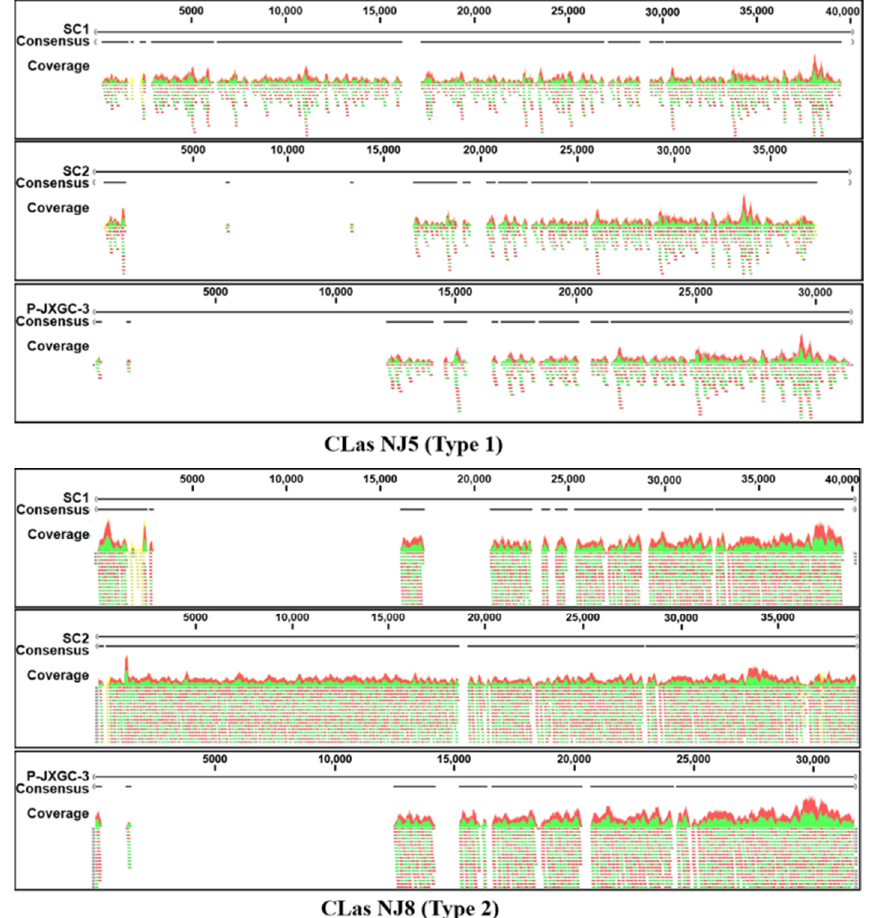
Figure 2. Results of HiSeq read mapping of “ Candidatus Liberibacter asiaticus” (CLas) strains NJ5-T1 and NJ8-T2 to the sequences of phage/prophage SC1 (Type 1, HQ377372), SC2 (Type 2, HQ377373) and P-JXGC-3 (Type 3, KY661963). Numbers at the top are nucleotide positions. On the left and under each prophage names, consensus = assembled contigs; coverage = read coverage. Note the almost complete coverage of SC1 by CLas NJ5-T1, indicating the presence of Type 1 phage, and the almost complete coverage of SC2 by NJ8-T2, indicating the presence of Type 2